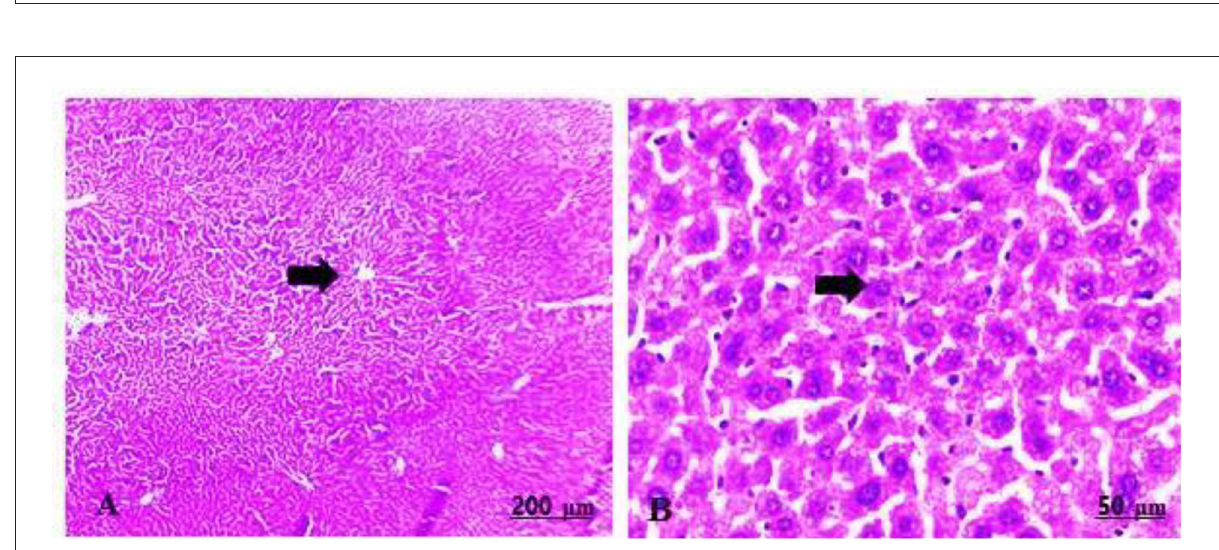
FIGURE6 (A,B) Light photomicrograph sections from maternal liver of control group showing normally arranged hepatic cords and blood